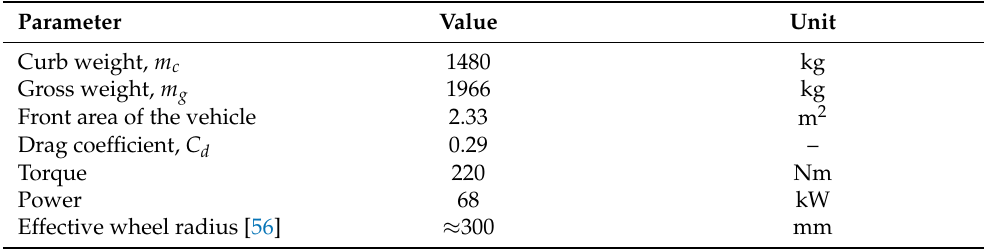
Table 2. Specification/metadata for Renault Zoe EVs utilized in this